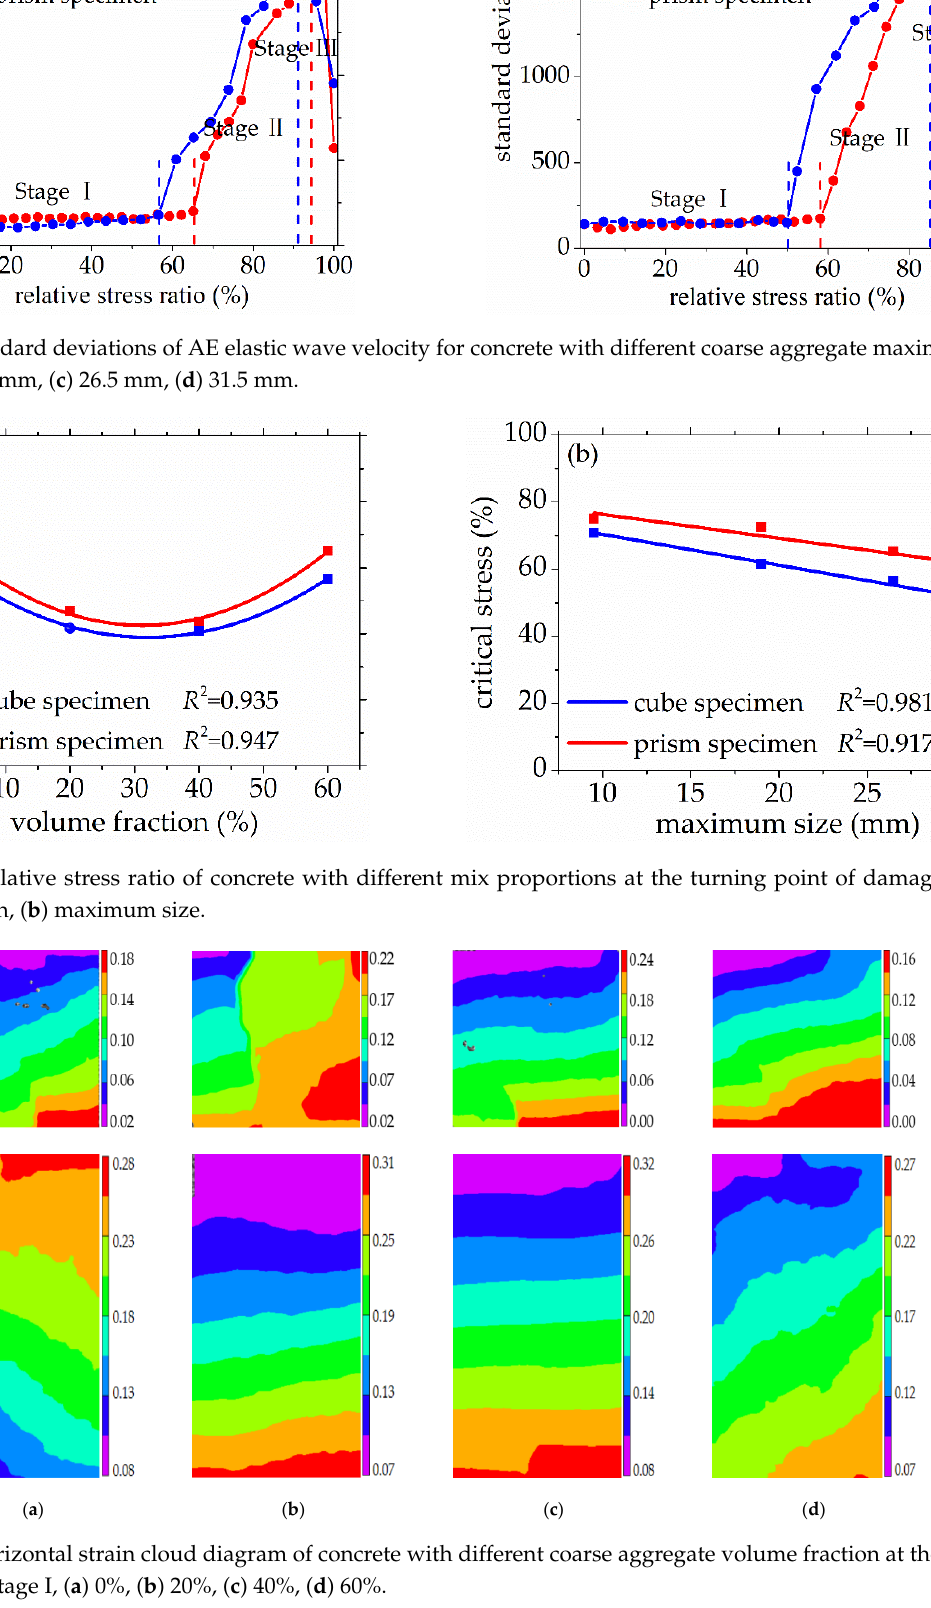
Figure 11. The horizontal strain cloud diagram of concrete with different coarse aggregate volume fraction at the turning point of damage stage I, ( a ) 0 %, ( b ) 20 %, ( c ) 40 %, ( d ) 60 %.